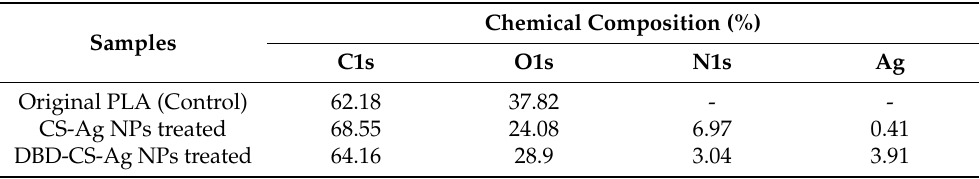
Figure 6. XPS survey scan of PLA nonwoven fabrics: ( a ) control; ( b ) CS-Ag NPs treated; ( c ) DBD-CS- Ag NPs treated. Table 1. Relative surface chemical composition determined by XPS for the control and the Ag NPs loaded PLA